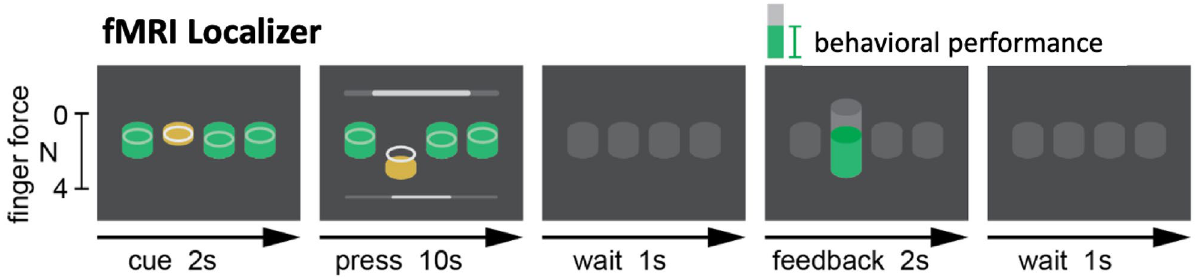
Figure 2. Experimental task protocol. Participants were cued to press one finger for 10 s while maintaining a constant force on the non-cued fingers. Feedback representing the number of correct presses was presented at the end of each trial. This process was repeated for 8 runs of 20 trials each.